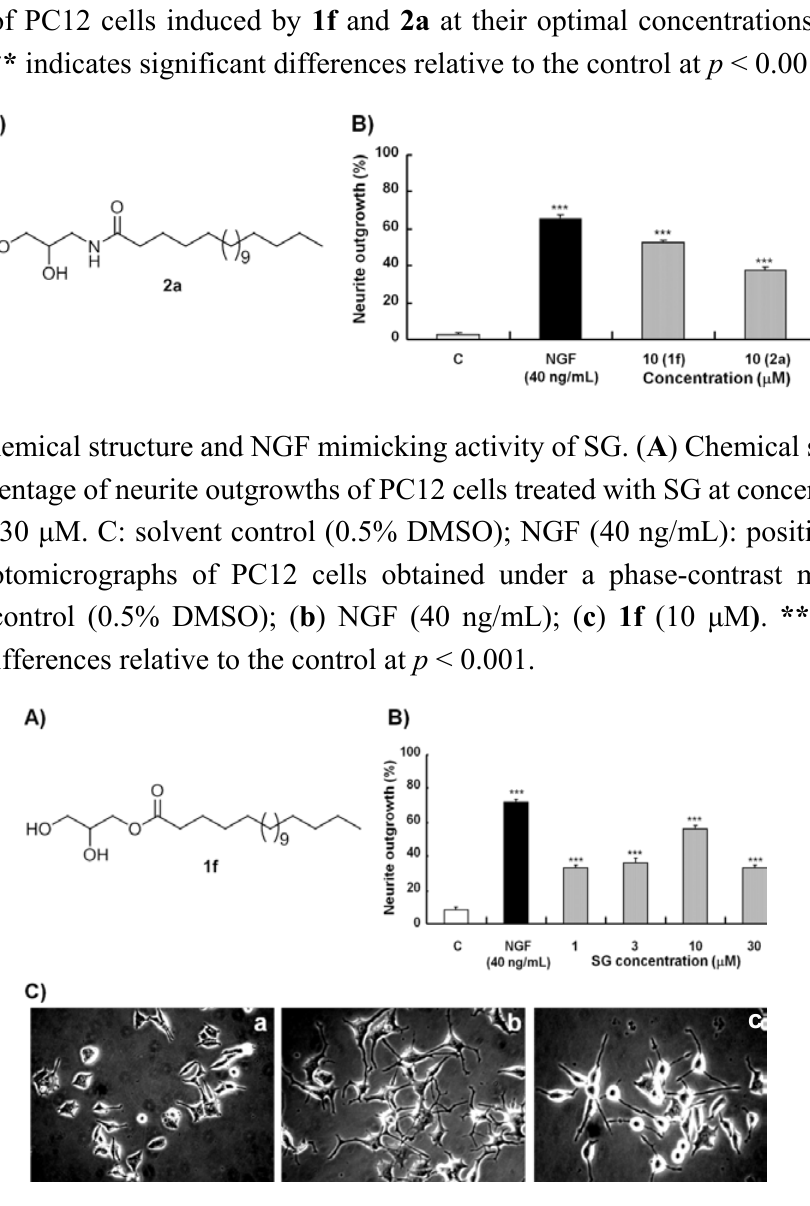
Figure 3. Chemical structure of 2a and the neuritogenic activity of monoglyceride derivatives with different linkages. ( A ) Chemical structure of 2a ; and ( B ) Percentage of neurite outgrowths of PC12 cells induced by 1f and 2a at their optimal concentrations 48 h after treatment. *** indicates significant differences relative to the control at p < 0.001.